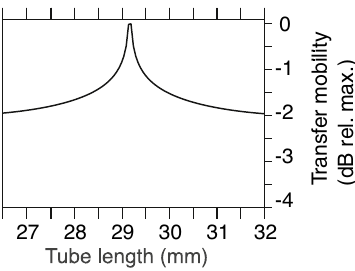
27 28 29 30 31 Figure 8. The transfer mobility for the lancet at 29.75 kHz. The needle tube was excited flexurally at 29.75 kHz, and vibration was measured at the tip and presented as the magnitude of the transfer mechanical mobility (dB relative to maximum), for TLs 26.5–29.5 mm (step size 0.1